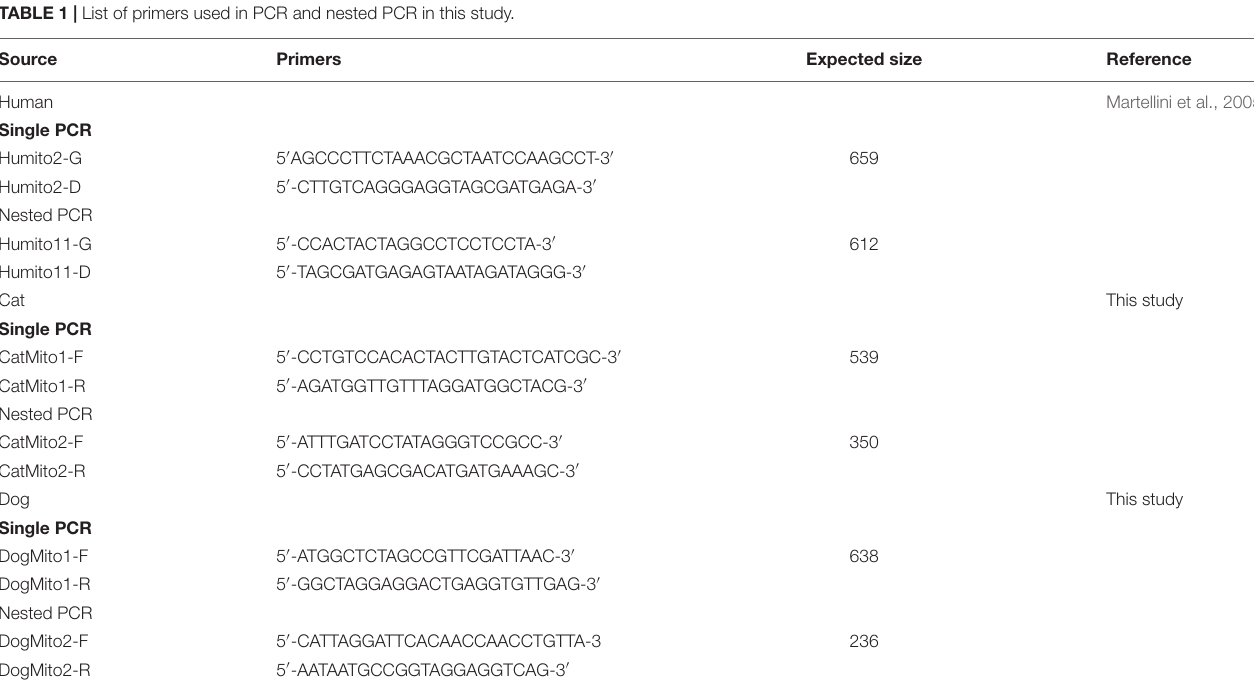
TABLE 1 | List of primers used in PCR and nested PCR in this